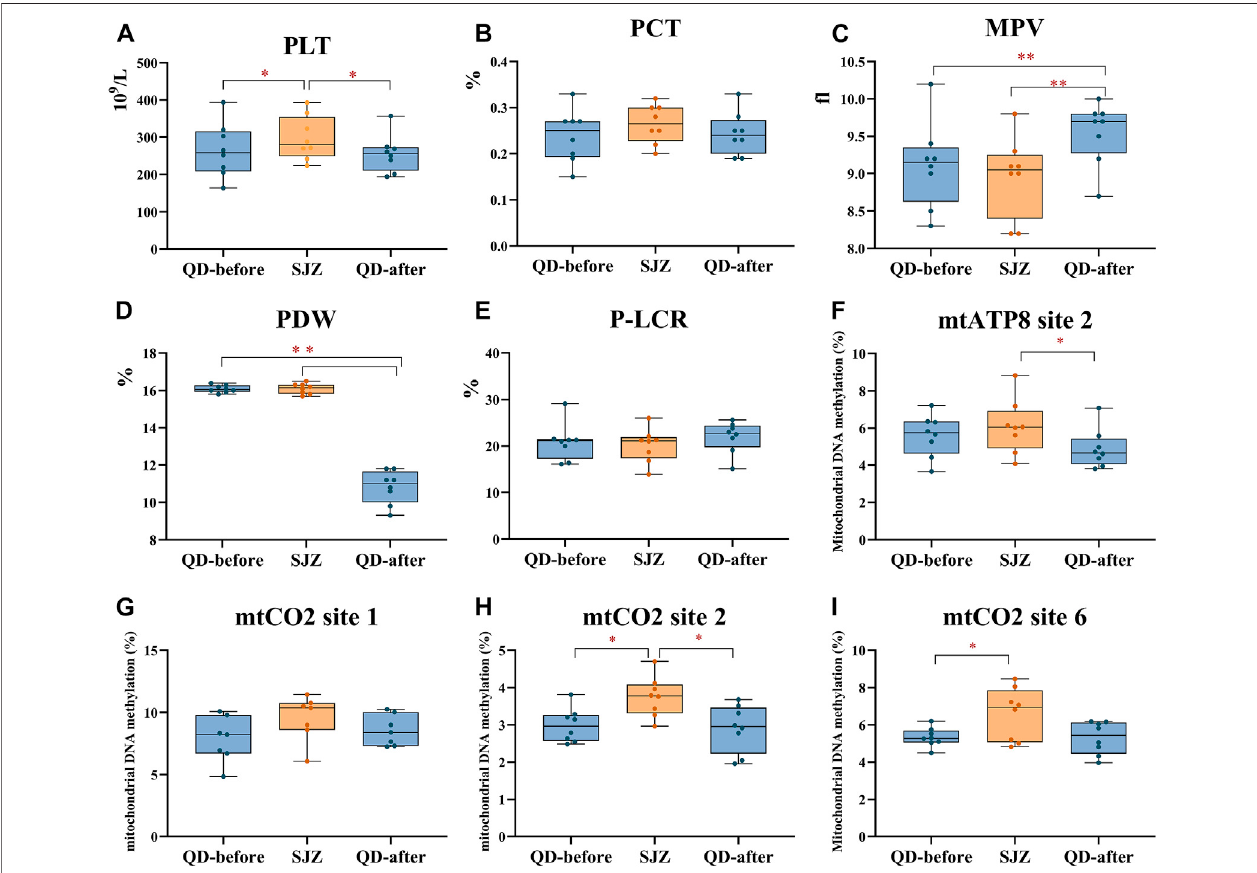
FIGURE 3 | Thrombocyte parameters in 8 participants at three periods. Yellow and blue solid dots represent samples from Shijiazhuang and Qingdao periods, horizontallinesinboxesrepresentthesamplemedian,andboxesrepresentthe25th – 75thpercentiles.*Falsediscoveryrate < 5%afterBenjamini – Hochbergadjustment. **False discovery rate < 1% after Benjamini – Hochberg adjustment. (A-E) respectively represent the parameters of PLT, PCT, MPV, PDW, and P-LCR in the blood of participantsatthreeperiods.(F-I)successivelyrepresentsthemethylationlevelsofparticipants'plateletsatmtATP8site2,mtCO2site1,mtCO2site2,andmtCO2 site 6 at the three